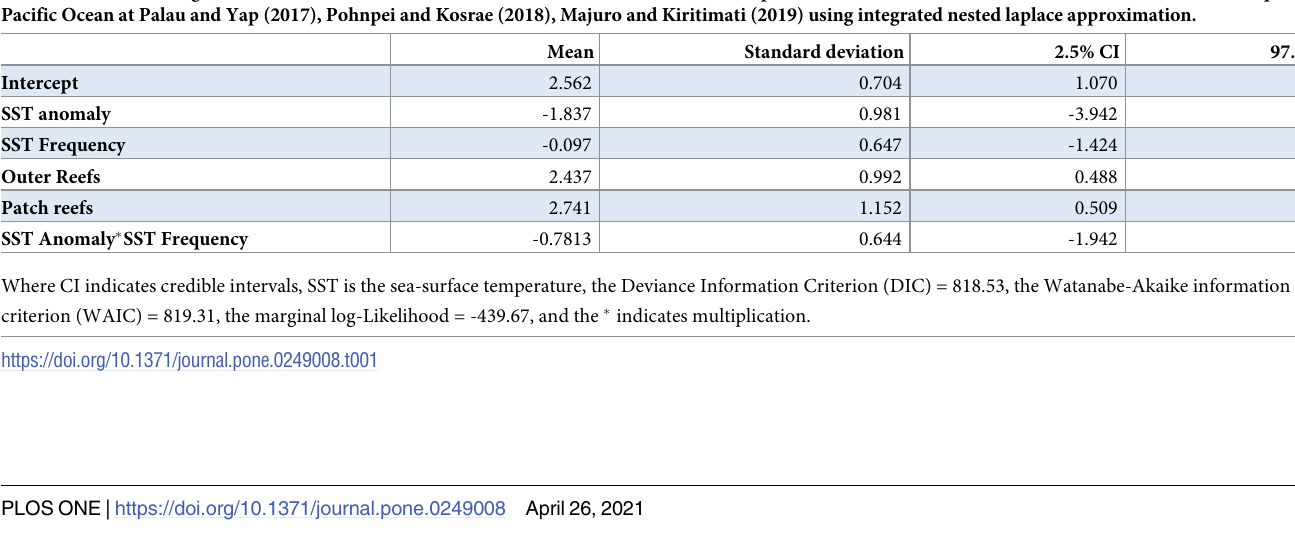
Table 1. Posterior marginal distributions of fixed effects of the best-fit model for carbonate production rates and environmental covariates across the tropical Pacific Ocean at Palau and Yap (2017), Pohnpei and Kosrae (2018), Majuro and Kiritimati (2019) using integrated nested laplace approximation. Mean Standard deviation